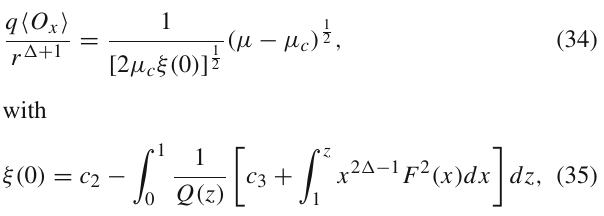
Fig. 2 The charge density as a function of the chemical potential for differentvaluesofGauss–Bonnetparameter α withthefixedmassofthe = − 3 / 4 , 0 , 5 / 4, respectively in the holographic p- vector field m 2 L 2 ef f wave superfluid model in AdS soliton. In each panel the five lines from